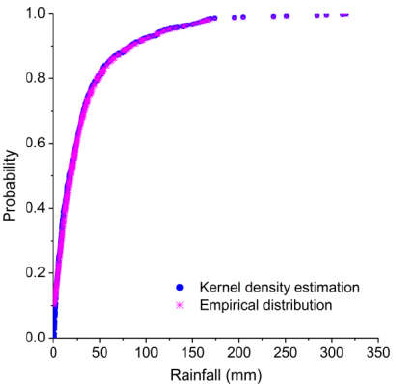
Figure 6. Cumulative probability distribution of rainfall.